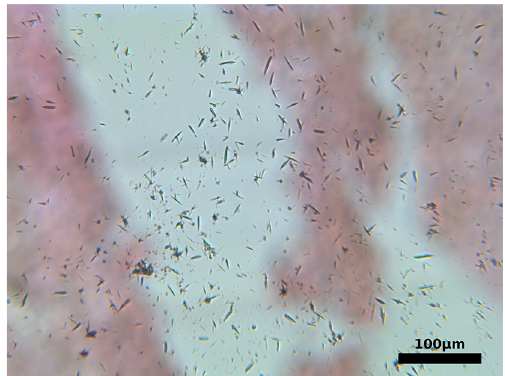
Figure 2. Microscope image of needle shaped MSU crystals, which were extracted from the knee of a leopard